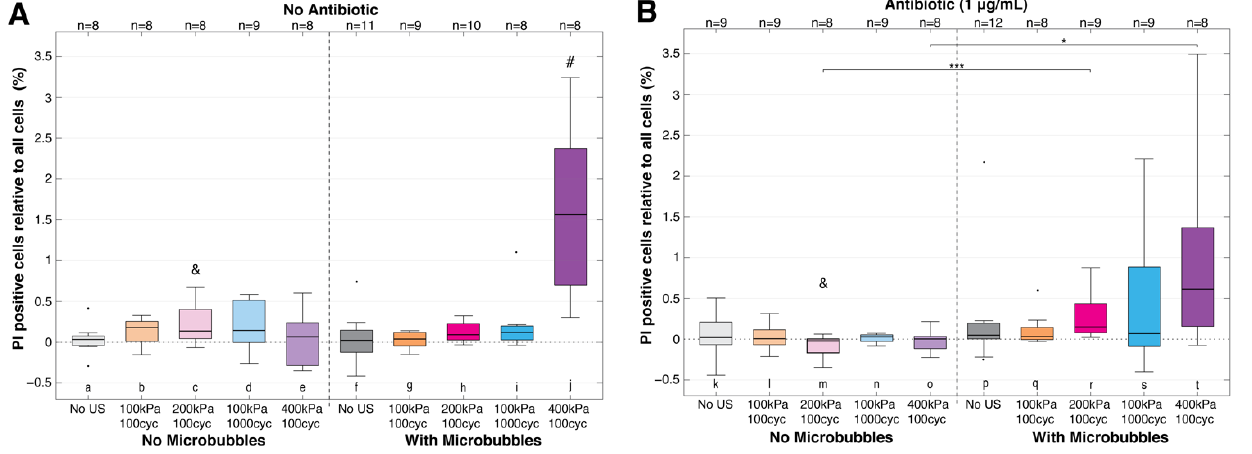
Figure 6. Sonoporation relative to all cells in field-of-view (Equation (2). Sonoporation (%)). Key statistically significant differences are indicated with * p < 0.05 or *** p < 0.001. Black circles denote outliers. Statistical significance from all other groups within the same graph are marked by a (#). If adding an antibiotic ( B ) was different from the same treatment without ( A ), that is denoted with (&) for p < 0.05. cyc = cycles; PI = propidium iodide; US = ultrasound. See Supplementary Table S3 for all statistical comparisons.